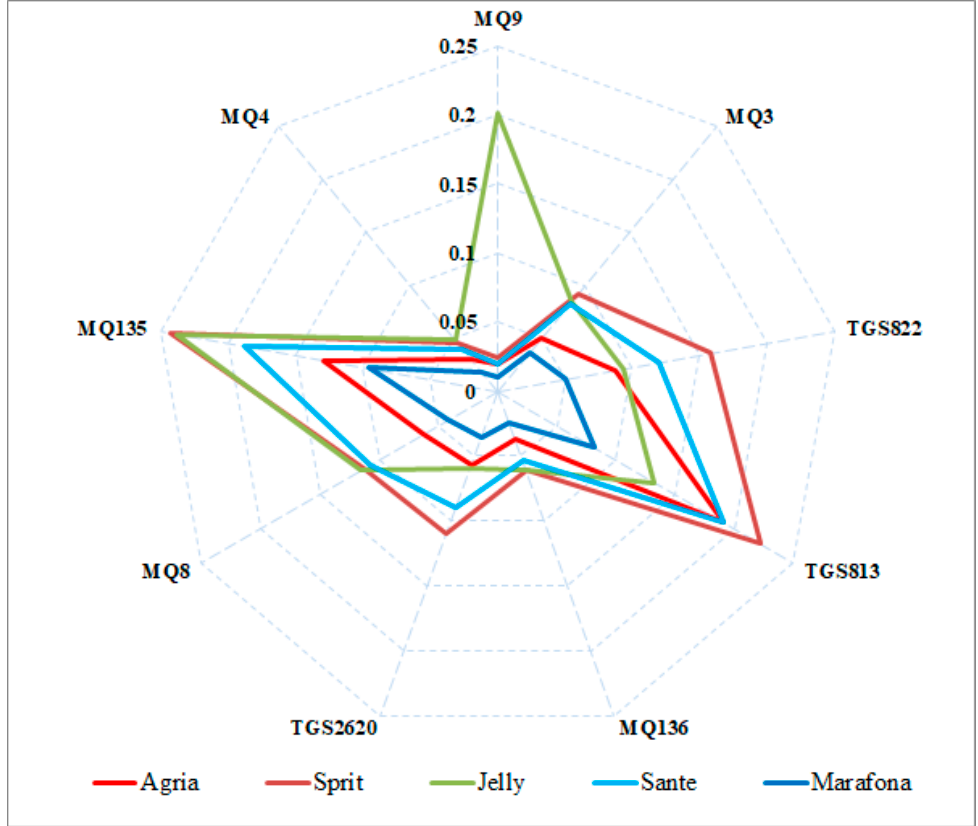
Figure 4. Radar raw fingerprint chart (sensor intensities) of the VOCs potato cultivars.